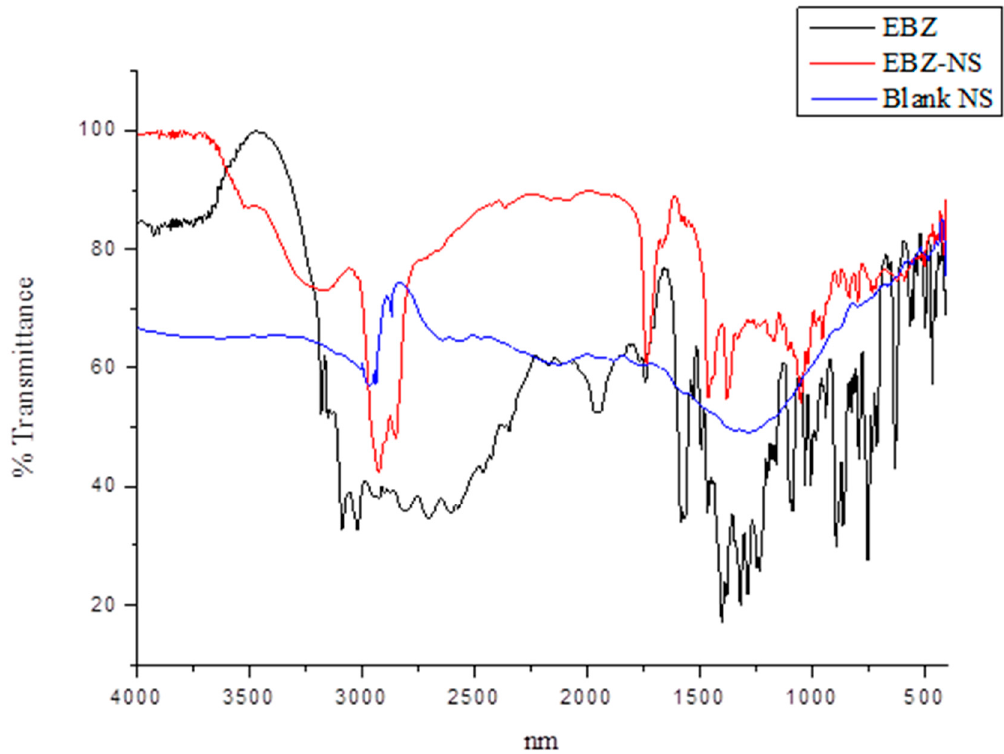
Figure 6. Combined spectra of EBZ, EBZ-loaded niosomes, and blank niosomes.